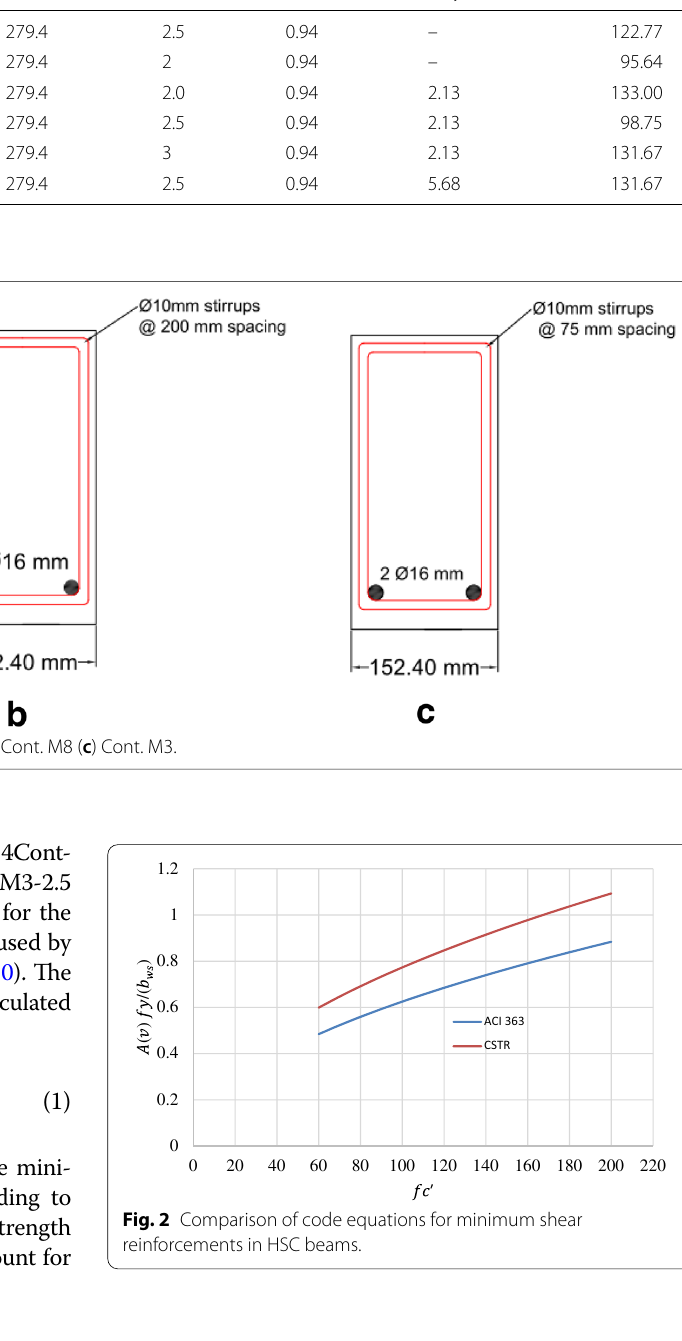
Table 3 Details of beam specimens and experimental results. Beams